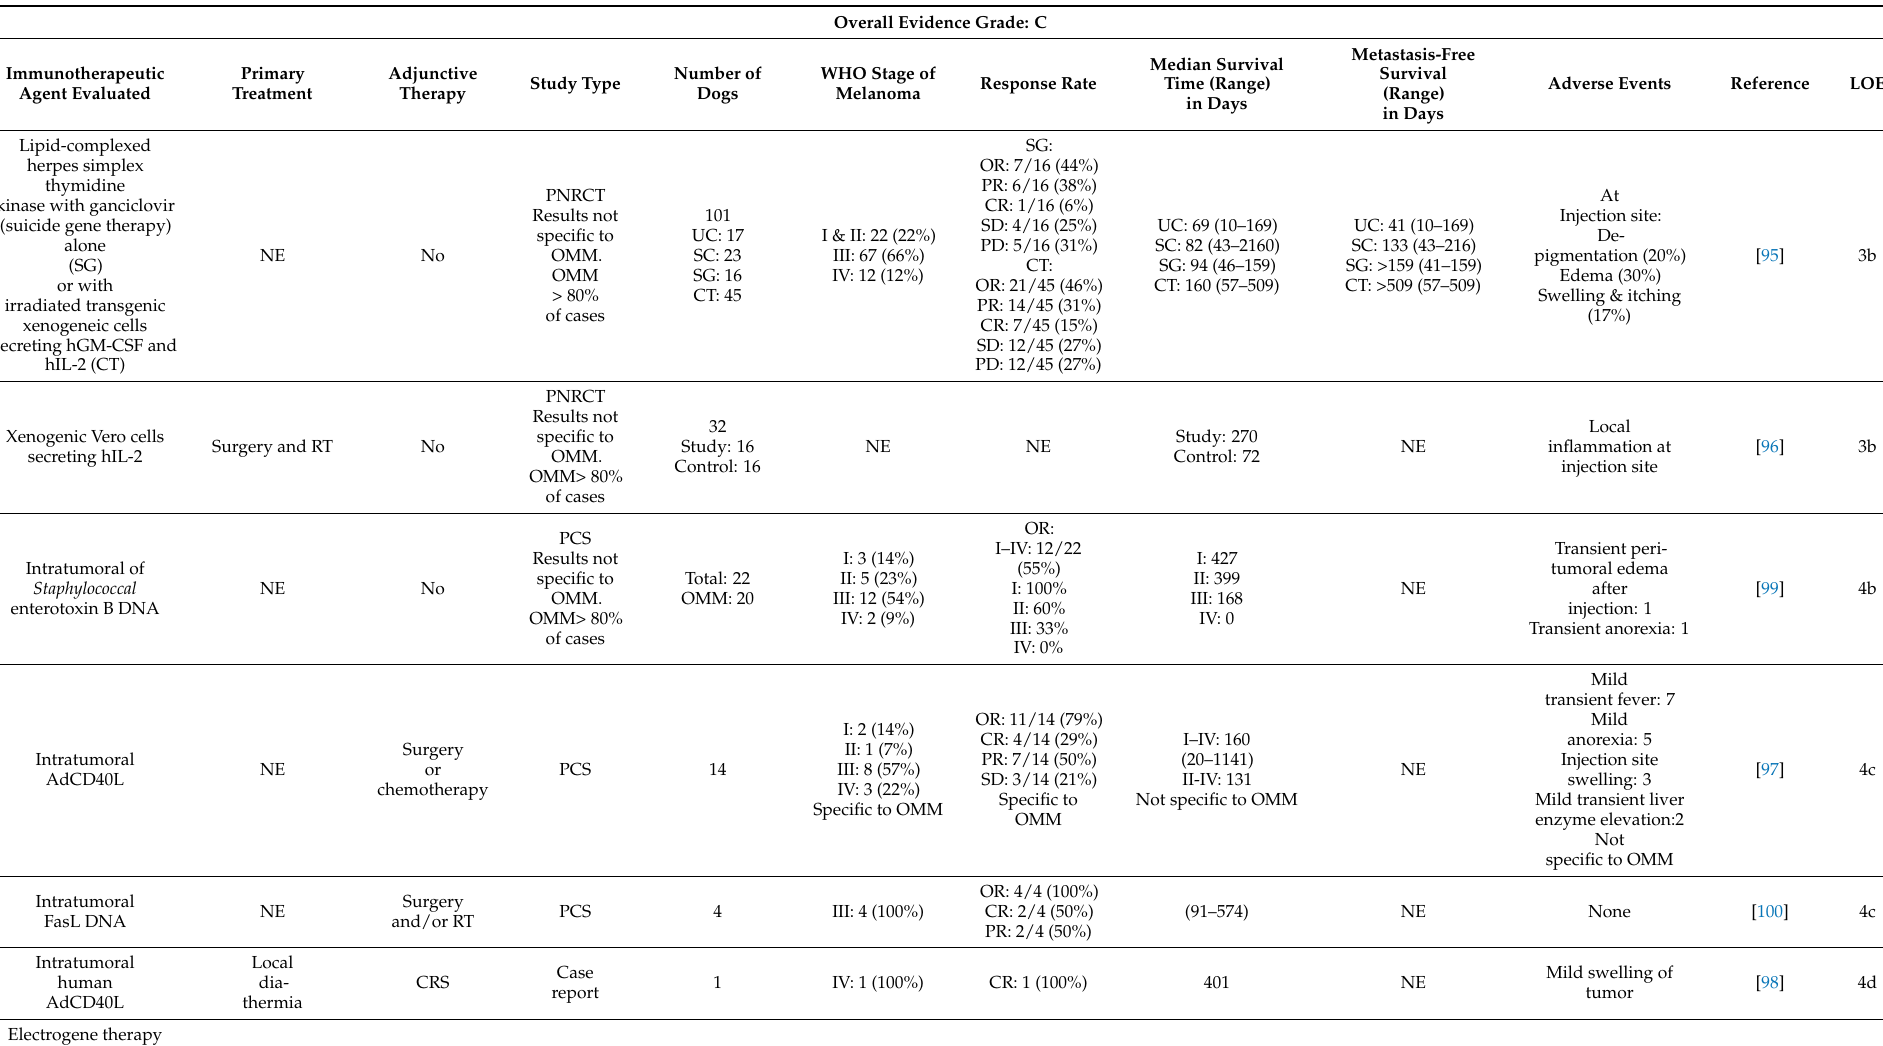
Table 12. Summary of gene therapy studies evaluating effectivity in oral malignant melanoma. Overall Evidence Grade: